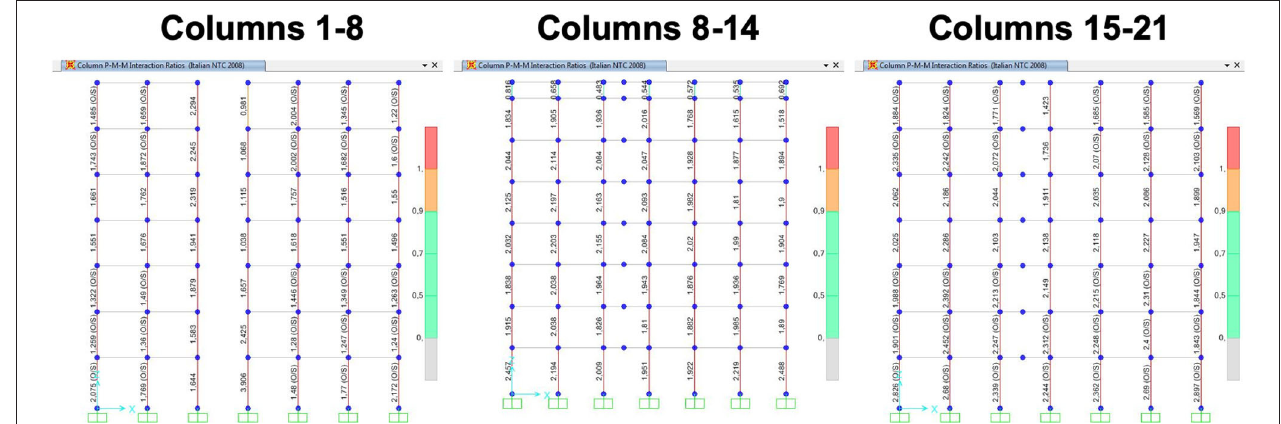
FIGURE 5 | Existing columns. Structural verifications with respect to the axial and bending moment. Verifications are performed with respect to the design combinations including the seismic action.